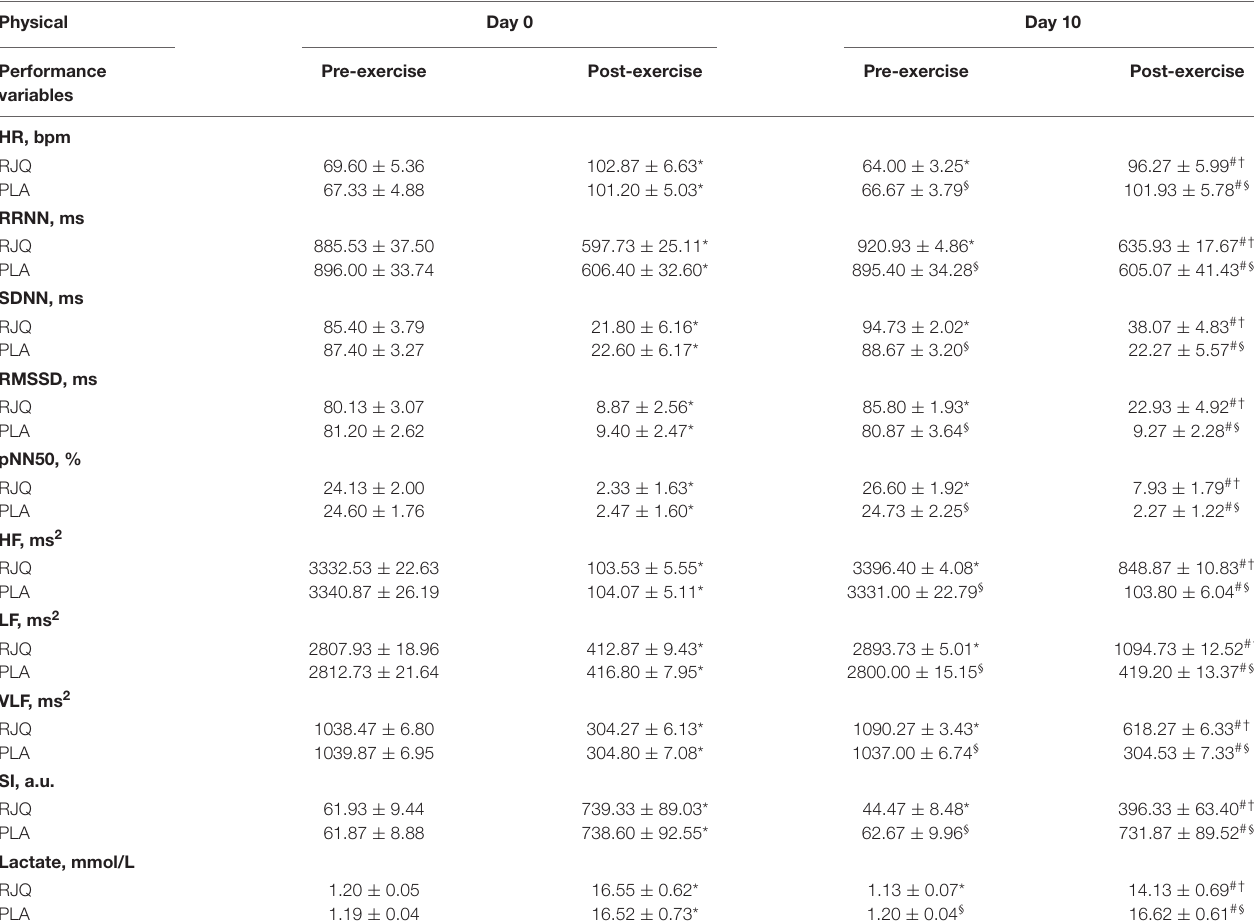
TABLE 1 | Heart rate variability indices and blood lactate concentration before and immediately after high-intensity interval exercise at baseline and day 10 of intervention between randomization